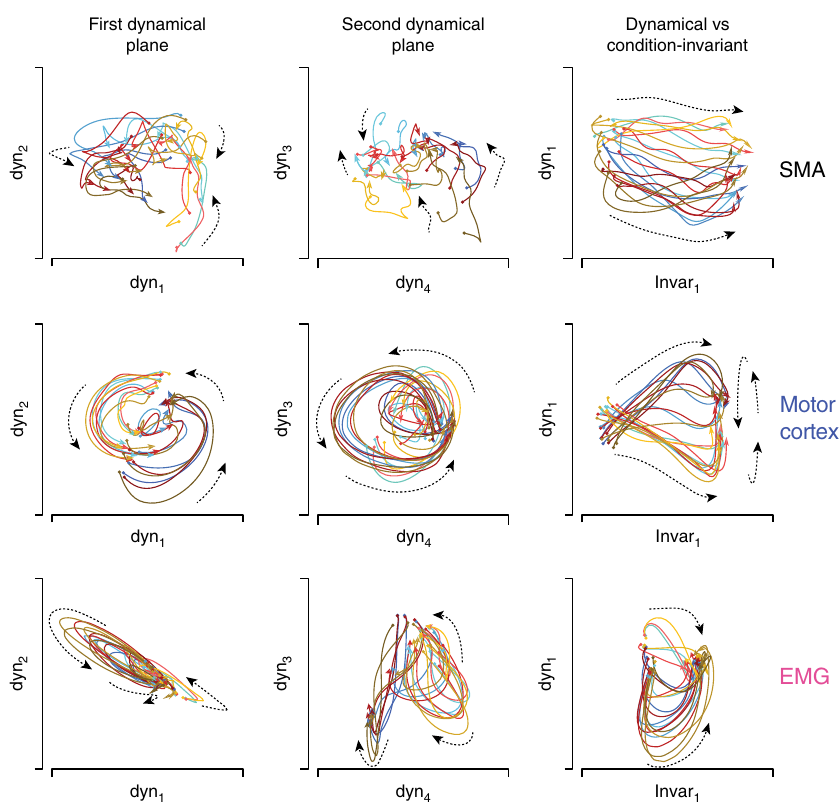
Fig. 4 State-space plots of the latent variables identi fi ed by HDR for monkey Ba. HDR was applied separately for SMA, motor cortex, and muscle populations. Each sub-panel plots the joint evolution of two latent variables (equivalent to a projection of the full neural state onto two dimensions). Each colored trajectory corresponds to one condition and plots the values of the latent variables from − 80 to 150 ms relative to movement onset. The beginning and end of each trajectory is indicated by a circle and arrow, respectively. Color-coding is as in Figs. 1a, b and 2a – c: red, blue, and yellow trajectories correspond to the three contexts, while darker/lighter traces correspond to leftward/rightward movements. Dashed lines are included to aid visualization and indicate the local direction of fl ow (this was often less consistent for SMA and the muscles than for motor cortex). Scaling is arbitrary but the same scale is always used for the horizontal and vertical axis within each